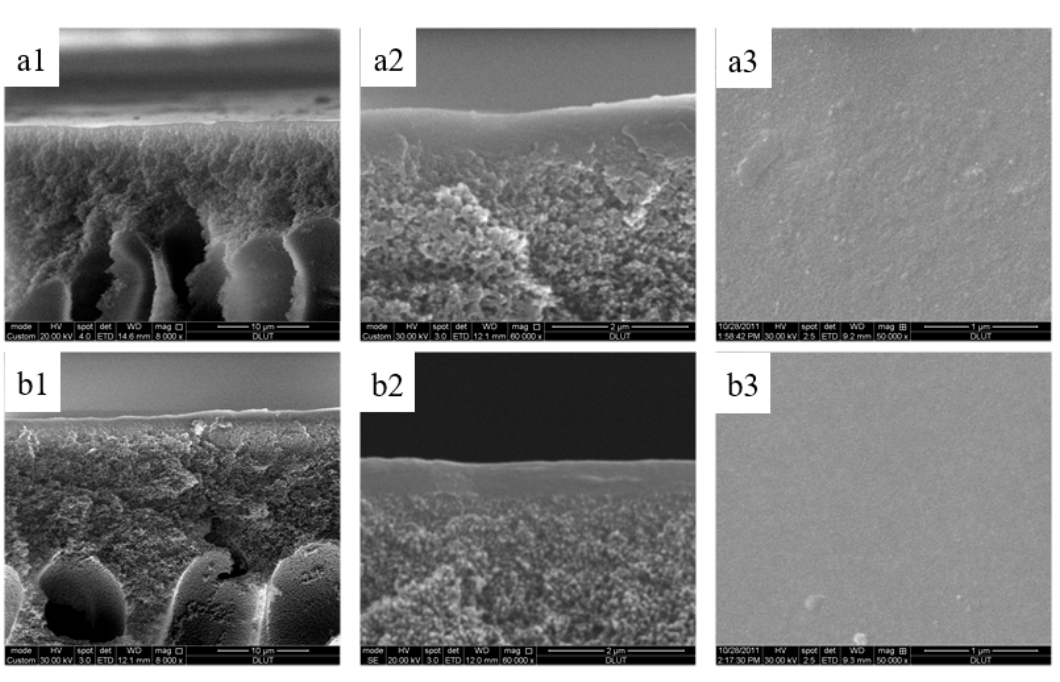
Figure 7. The morphologies of composite membrane. a1 , b1 , and c1 are the cross sections of SPPES, SPPBES, and SPPHES, respectively, at 8000×. a2 , b2 , and c2 are the cross sections of SPPES, SPPBES, and SPPHES, respectively, at 60000×. a3 , b3 , and c3 are the surface of SPPES, SPPBES, and SPPHES, respectively. 4. Conclusions Composite membranes were prepared using sulfonated copoly(aryl ether sulfone) with different amounts of phthalazinone moieties (SPPES, SPPBES, SPPHES) as the selective layer via the dip- coating method. Four solvent systems used in preparing the coating solution were investigated, and EGME + ethanol (4:1) was selected as the optimal solvent system. The rejection of composite membranes with different active layers followed the sequence SPPES > SPPHES > SPPBES. The results revealed that SPPES composite membranes exhibited higher water flux and salt rejection than SPPBES and SPPHES. Composite membranes showed nanofiltration characteristics. The salt rejection of the three composite membranes decreased in the order Na 2 SO 4 > MgSO 4 > NaCl > MgCl 2 . The rejection of the three composite membranes decreased slightly as the solution temperature was raised from 20 to 90 °C, while the SPPES composite membrane showed a higher increase in the flux than others. The results indicate that composite membranes show good thermal stability, and the SPPES membrane shows better separation properties and thermal stability than others. After being immersed in 0.2 g/L sodium hypochlorite solution for 10 days, the solution flux of composite membranes decreased less than 1.7%, indicating the good chlorine resistance of the three sulfonated poly(aryl ether sulfone) composite membranes. There was no obvious difference in the morphologies between SPPES, SPPBES, and SPPHES composite nanofiltration membranes.